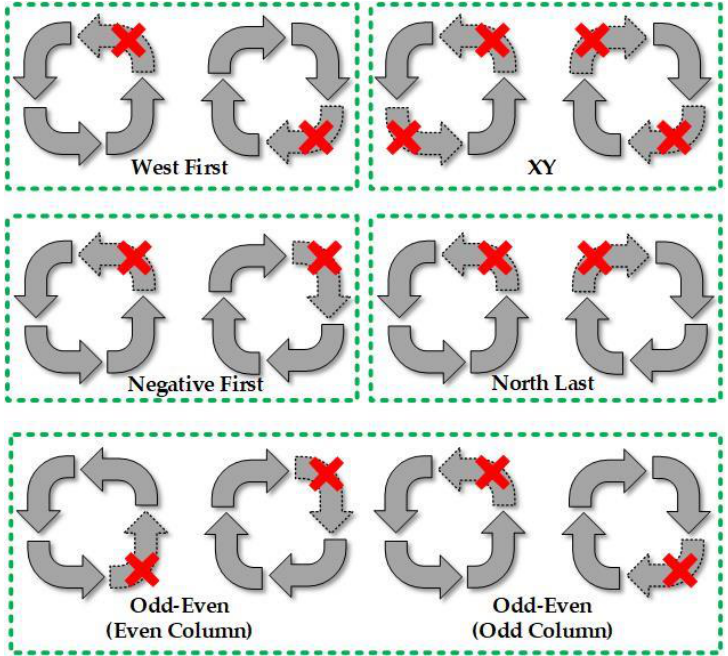
Figure 1. Restricted turns in different deterministic and partially adaptive routing algorithms.